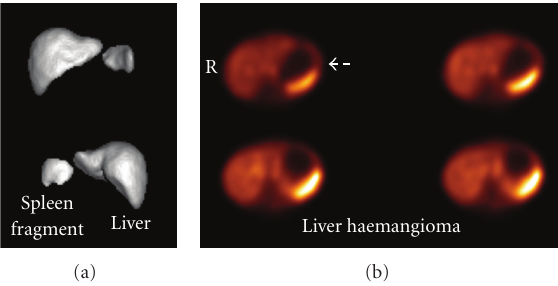
Figure 10: 3D liver surface images. (a) Liver and spleen fragment caused by accident. Images reconstructed by FBP, prefiltered by Hanning (critical value 0.8 cm − 1 ) and ramp filter. (b) Haemangioma of liver. Images reconstructed by FBP, prefiltered by Butterworth (cut o ff 0.5 cm − 1 , power factor = 10) and ramp filter. ( Studies o ff ered by Radiation Physics Unit, Department of Radiology, University of